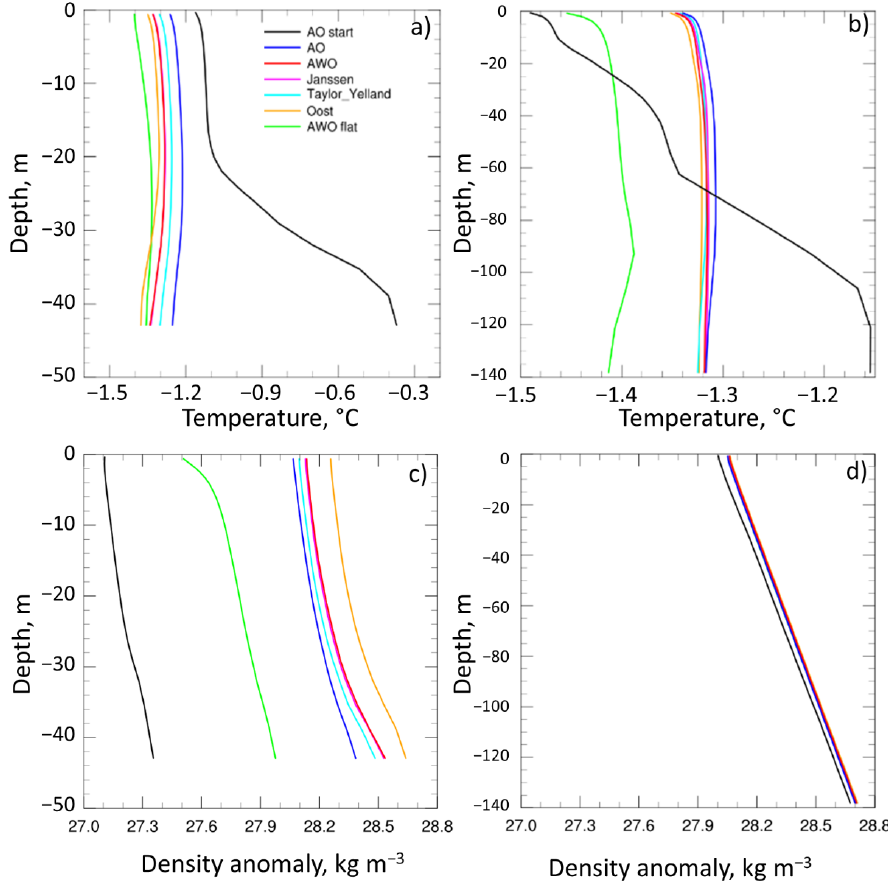
Figure 4. Water temperature ( a , b ) and density anomaly (density “minus” 1000) ( c , d ) vertical profiles averaged in 15-km radius from the points ( a , c ) 72.3° N, 51.9° E and ( b , d ) 76.6° N, 63.6° E at the beginning (00UTC on 10 December, black line) and the end (18UTC on 12 December, colored lines) of bora in different experiments.